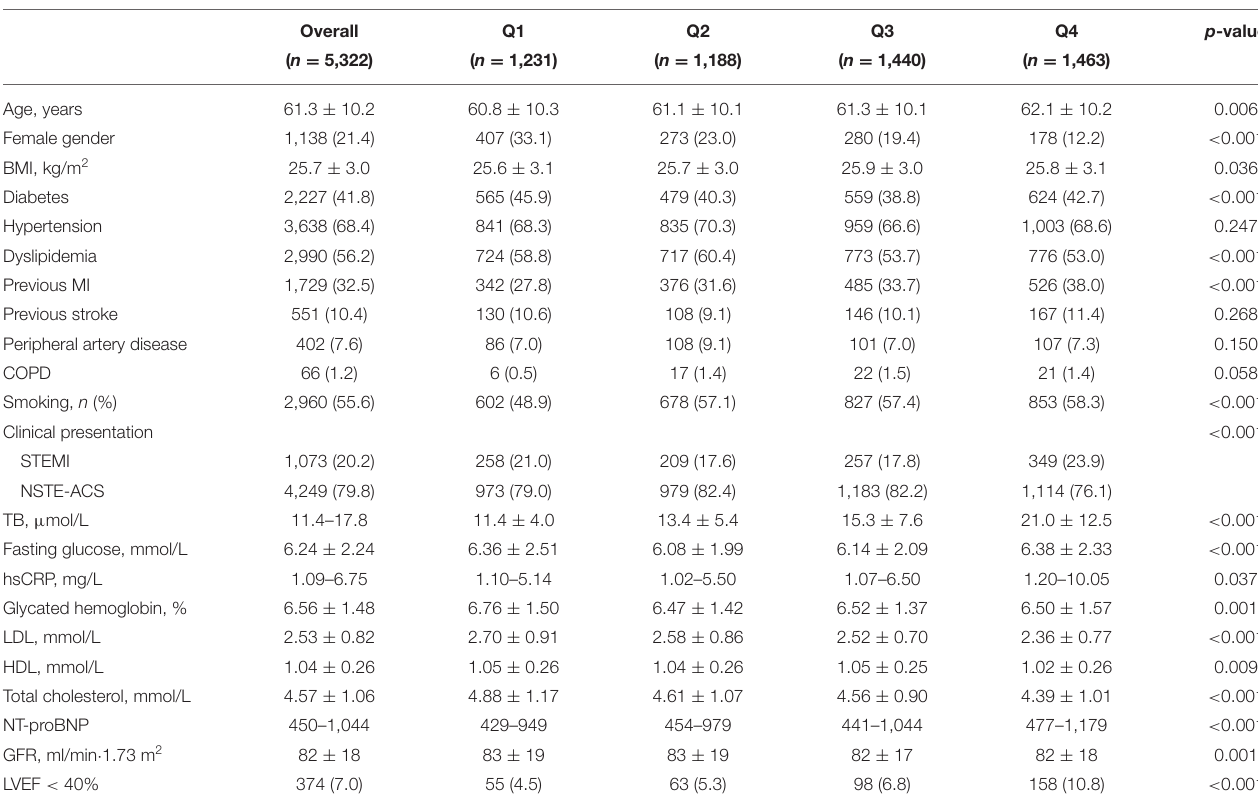
TABLE 1 | Baseline characteristics across DB